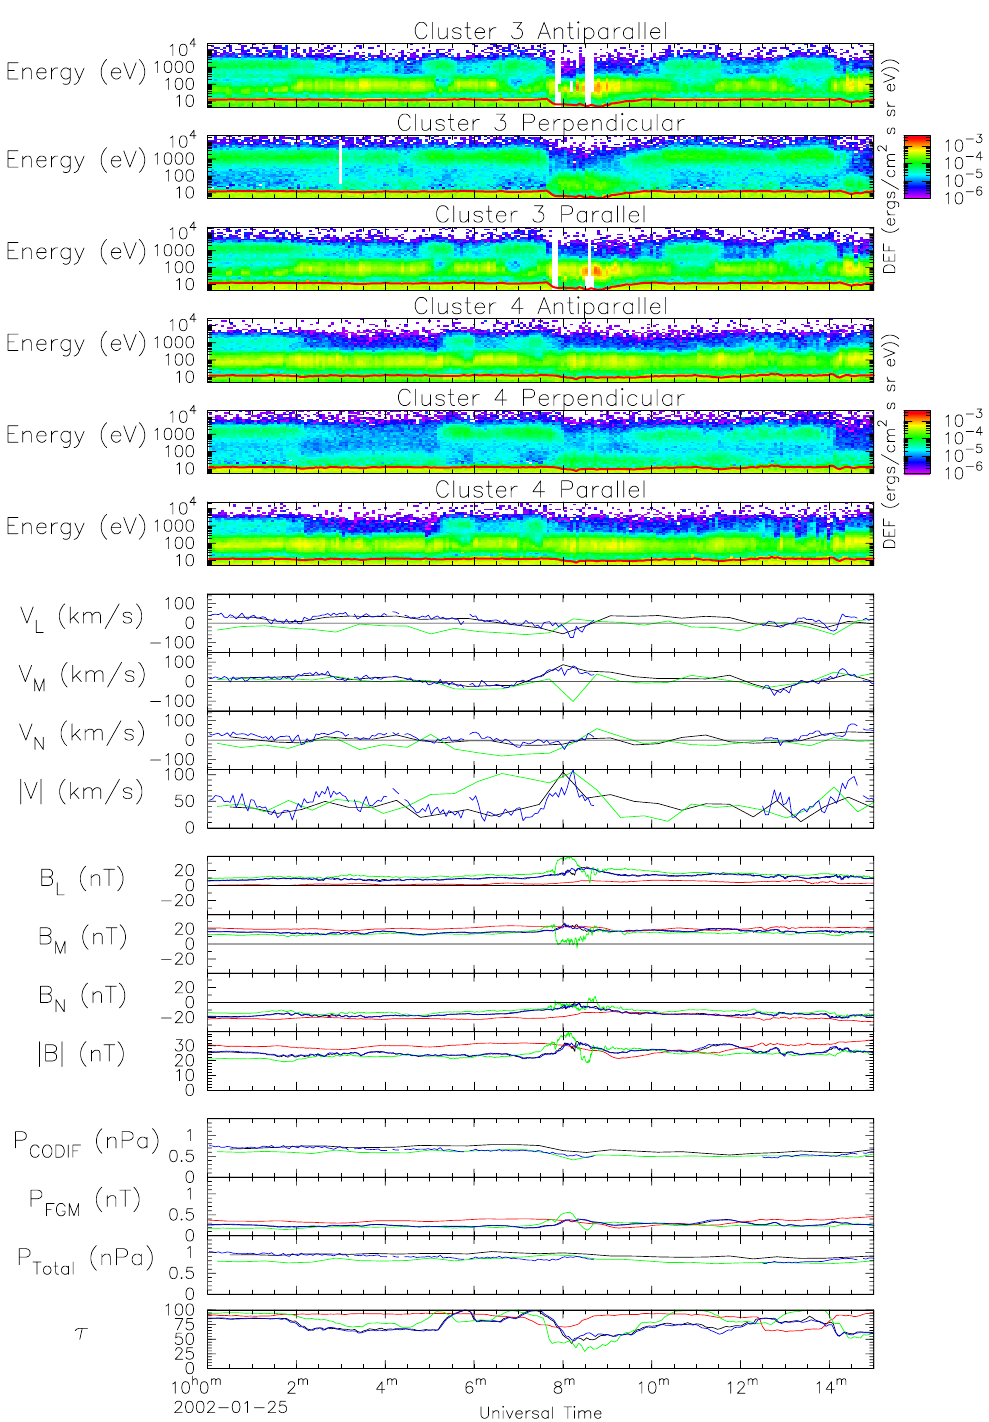
Fig. 7. Plasma and magnetic field data from the 10:08 UT event. The top six panels show electron spectrograms from Cluster 3 (closest to the magnetopause) and Cluster 4 antiparallel, perpendicular and parallel to the magnetic field. The Cluster 4 spectrograms show data resulting from on-board binning of measured data into pitch angle bins, but the Cluster 3 data have been rebinned on the ground, which results in some data gaps. The next four panels show the proton ground moment velocities in boundary normal coordinates for Clusters 1 and 4 (corrected for dead-time effects) and Cluster 3. They are followed by the high resolution magnetic field observed on each spacecraft (also in boundary normal coordinates), and the gas, magnetic and total pressures. The final panel shows the transition parameter calculated for each